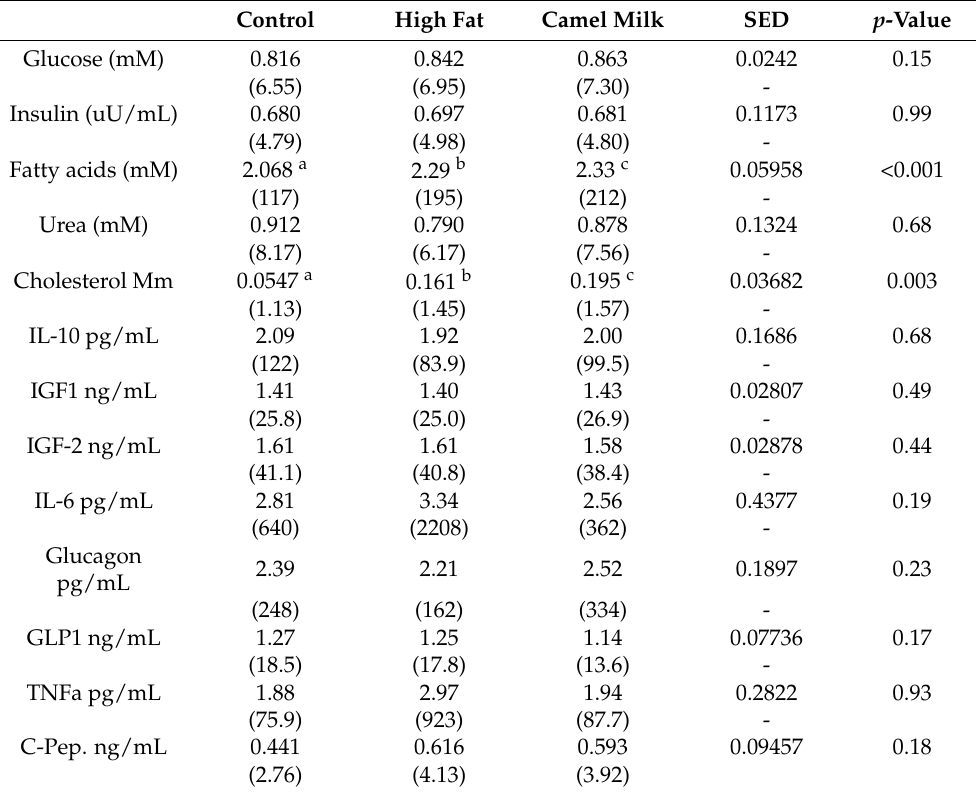
Table 2. Plasma glucose, fatty acids, and urea concentrations measured in growing female pigs (mean of two measurements at weeks 2 and 5 of a 6 week feeding period) fed either a control ( n = 5), high fat ( n = 5), or 500 mL per day camel milk (combination of raw and pasteurized, n = 10) diet. Values presented are back